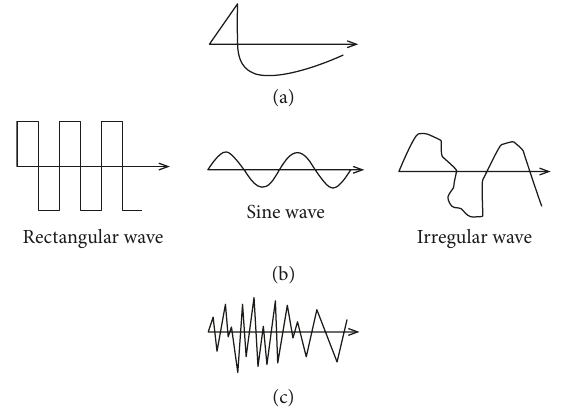
Figure 1: Schematic diagram of dynamic load waveform.